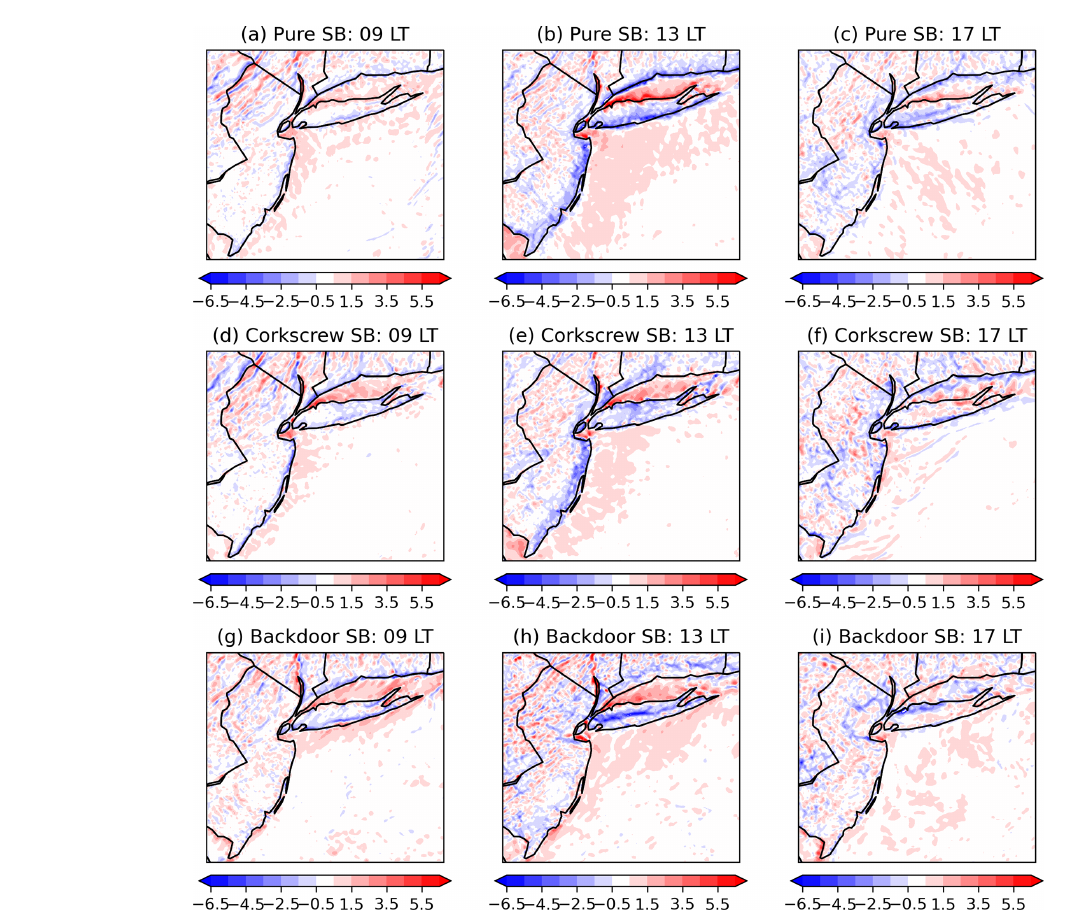
Figure 9. Spatial patterns of 10m divergence (scale of 10 − 4 s − 1 ) from the composite average of the pure sea breezes (a–c) , corkscrew sea breezes (d–f) and backdoor sea breezes (g–i) at 09:00, 13:00 and 17:00LT. The positive (negative) value indicates surface divergence (convergence).